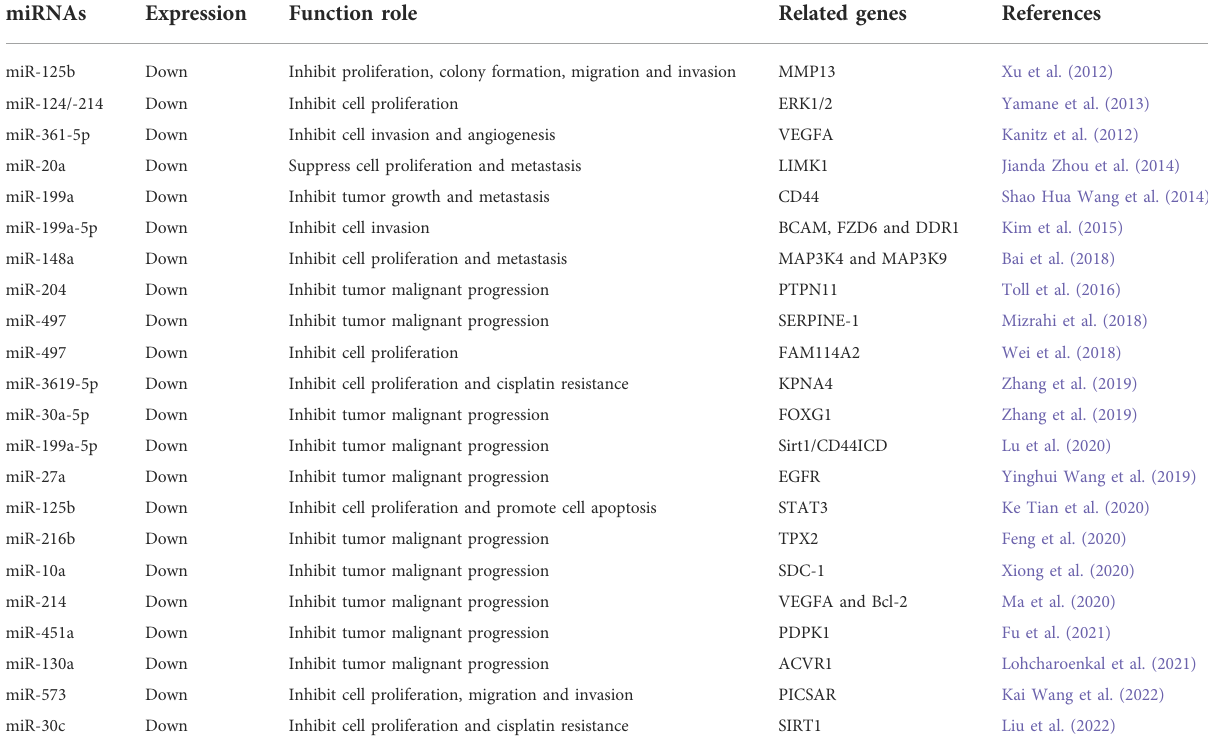
TABLE 3 Functional characterization of downregulated miRNAs in cutaneous squamous cell carcinoma.